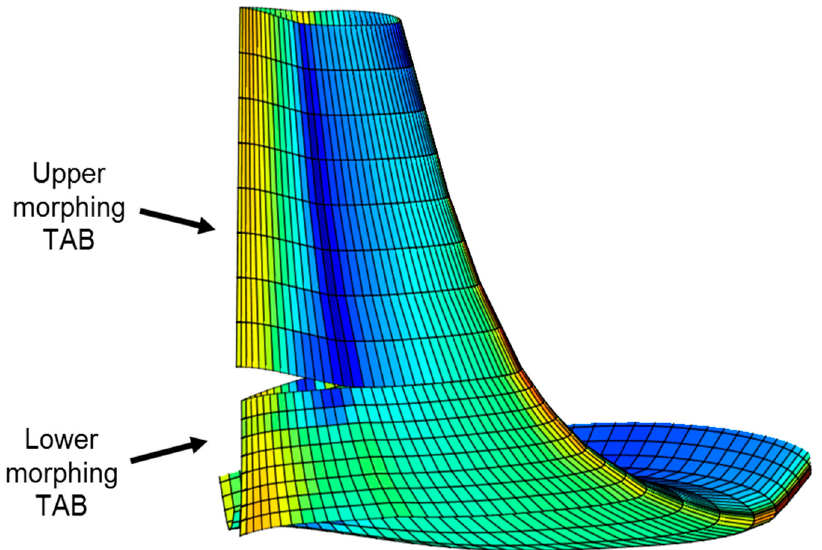
Figure 1. Morphing winglet concept with upper and lower control surfaces [24].